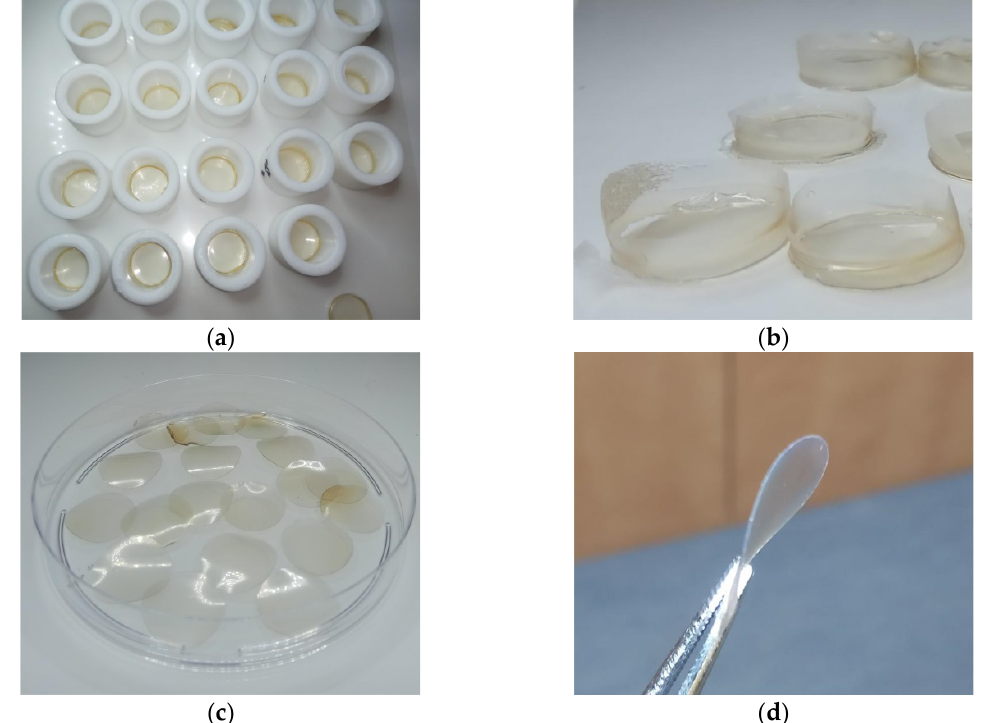
Figure 3. Keratin films: ( a ) Intermediate soft keratin films (KF-40) obtained in 20 mm Teflon rings; ( b ) KF-40 keratin films before punching; ( c ) 16 mm diameter KF-40 keratin films after punching; and ( d ) KF-110 keratin films after curing.